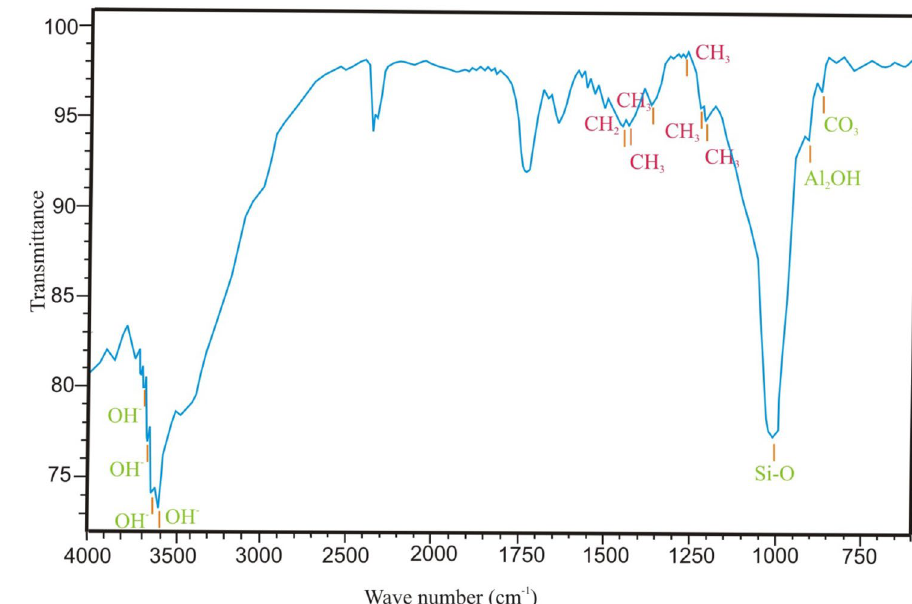
Fig. 11 The FTIR spectrum of sandstone–shale (the Penek For- mation) well sample. A single well; depth: 3532 m, sample 10